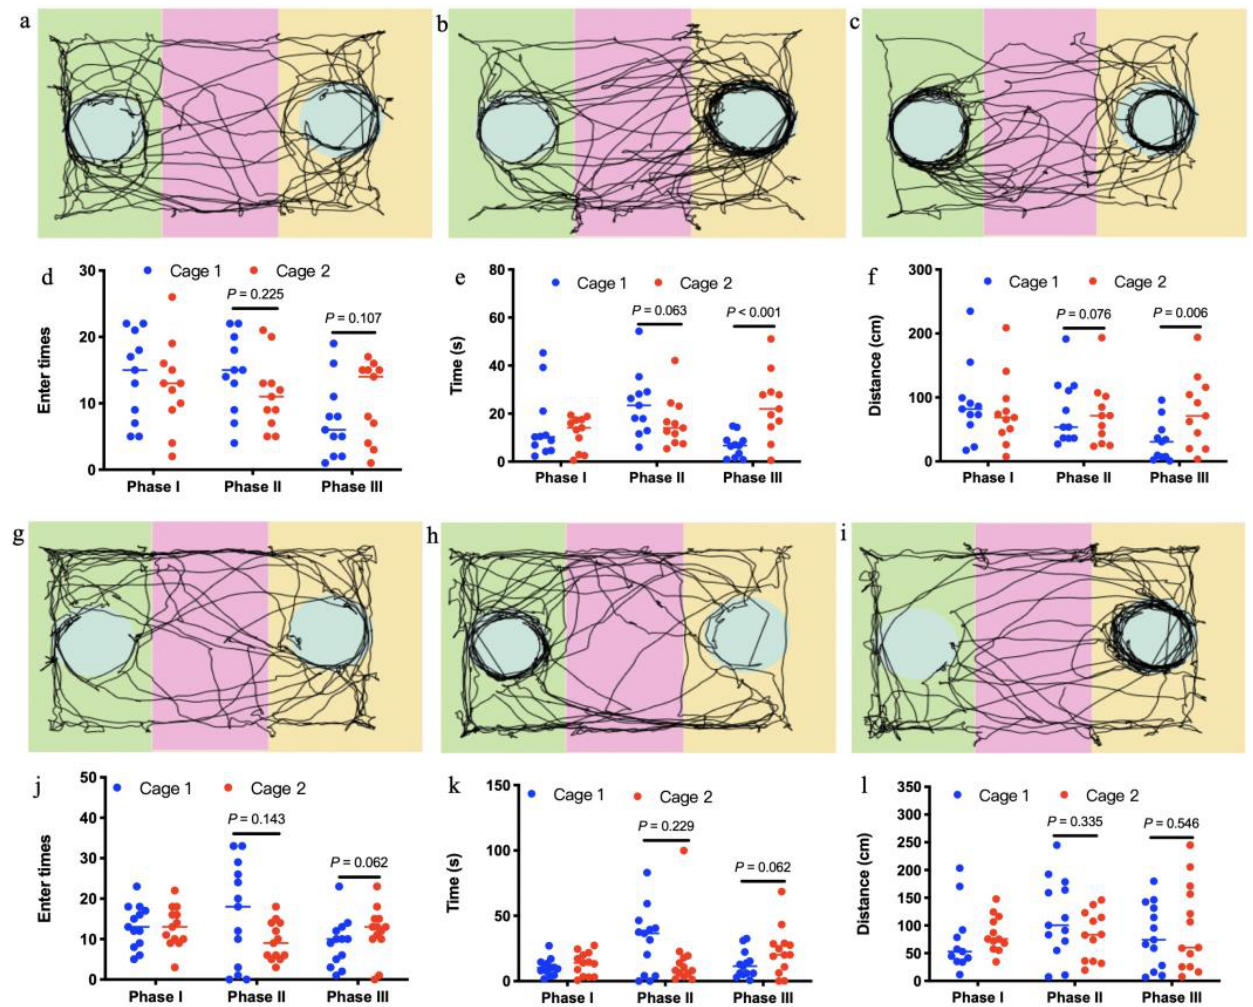
Figure 5. Social interactions of offspring mice born to control mothers ( a – f , n = 11) and those treated with antibiotics ( g , k , n = 13). In the three-chambered sociability test, offspring born to mothers treated with antibiotics showed reduced sociability and preference for social novelty displayed by those from controls, as seen in the automated tracking images at phase I ( a , g ), phase II ( b , h ) and phase III ( c , i ), the entry times in each chamber at phase I, II, and III ( d , j ), the time spent sniffing in each chamber at phase I, II, and III ( e , k ) and the travel distances in each chamber at phase I, II, and III ( f , l ).